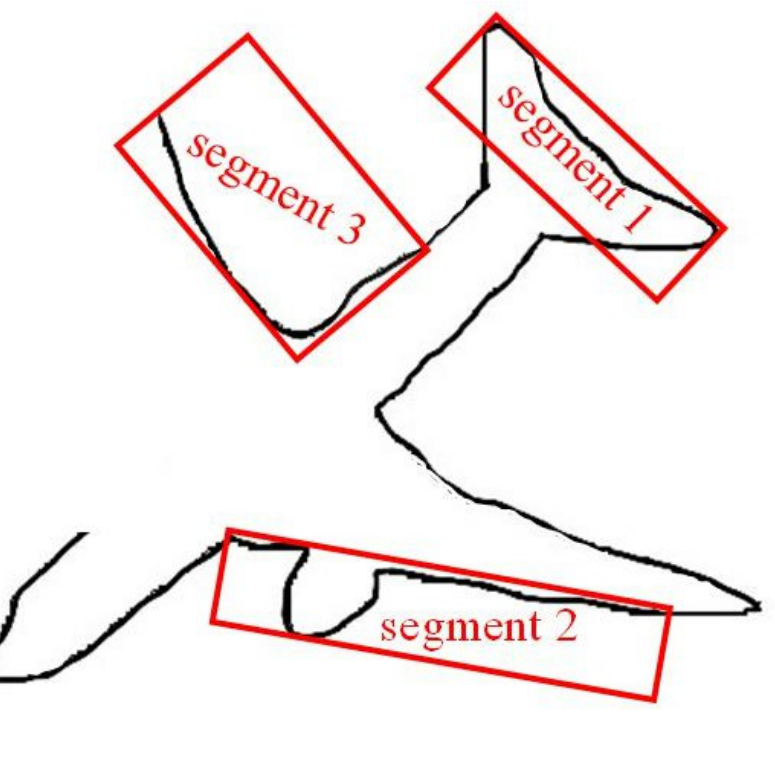
Figure 3. The partial contour of an occluded remote sensing aircraft target is shown in the figure. For the specified contour segment 1, segment 2, and segment 3, the red rectangle is the MBR of its